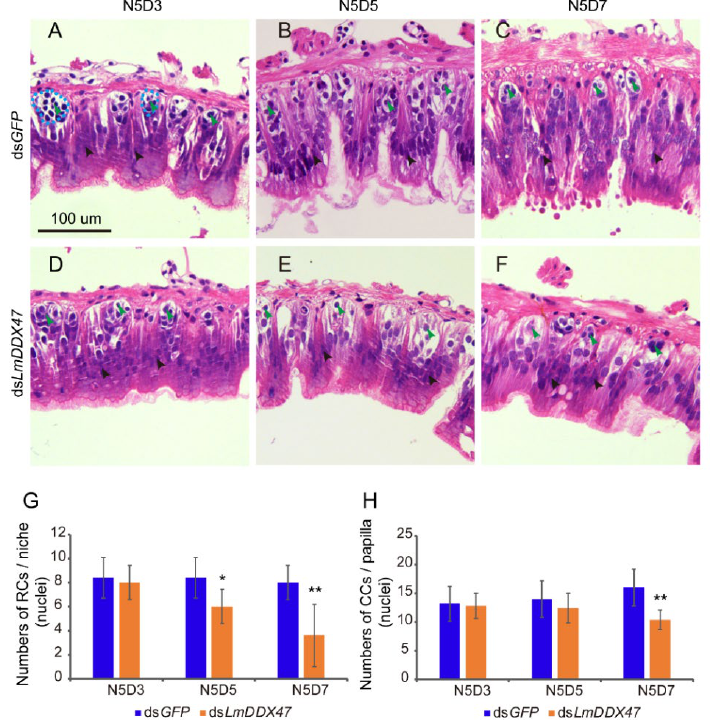
Figure 5. Effect of LmDDX47 RNAi on the histomorphology of the fifth instar nymph midgut. ( A – F ) Sections of the midgut of N5D3, N5D5, and N5D7 nymphs after ds GFP and ds LmDDX47 injections. The blue dotted circle indicates the regeneration niche. Green arrowheads indicate the regenerative cells in the niche, and black arrowheads indicate the columnar cells of the midgut. Scale bar = 100 μm, n = 8. ( G ) Number of regenerative cells (nuclei) per niche in the midgut of N5D3, N5D5, and N5D7 nymphs after LmDDX47 RNAi. ( H ) Number of columnar cells (nuclei) per papilla in the midgut of N5D3, N5D5, and N5D7 nymphs after LmDDX47 RNAi. RCs: regenerative cells; CCs: columnar cells. * p < 0.05; ** p < 0.01, n = 8.